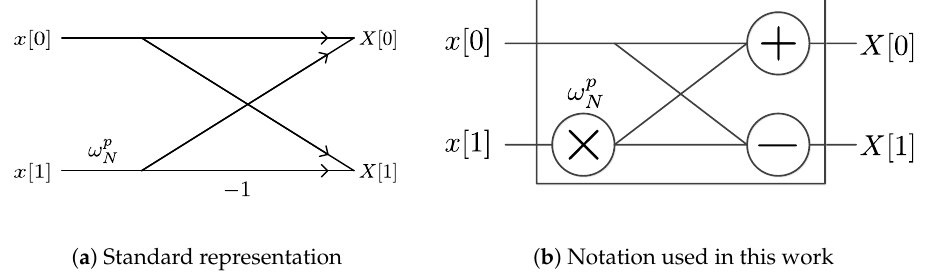
Figure 1. Representations for a 2-point Fast Fourier Transform (FFT) operation.